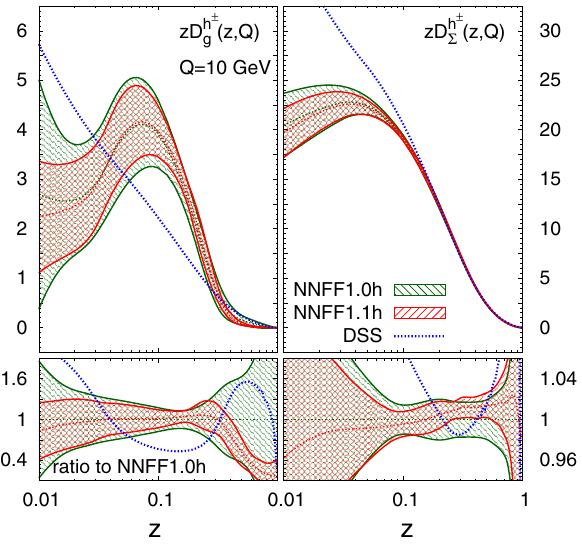
Fig. 2 The gluon (left) and singlet (right) FFs for the unidentified chargedhadronsfromNNFF1.0h,NNFF1.1h,andDSSat Q = 10GeV; the bands indicate the one- σ uncertainties. The ratio to NNFF1.0h is displayed in the bottom panels